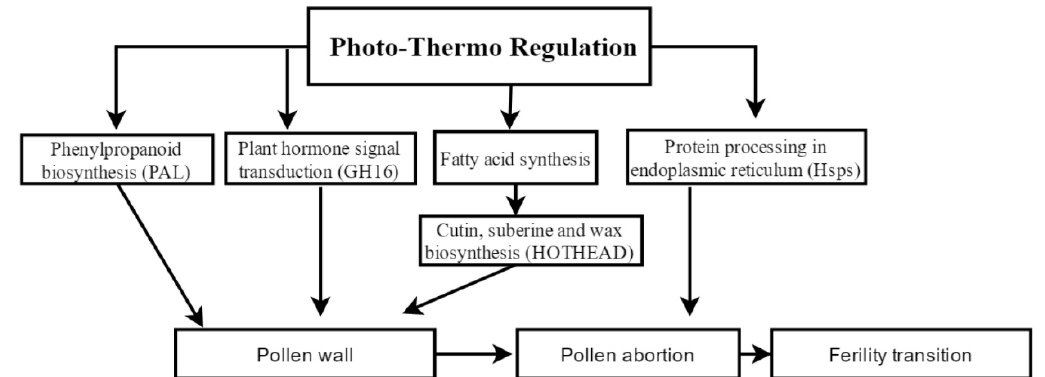
Figure 5. The proposed model of fertility transition mechanism in the PTGMS rice line WXS. Hsps, heat shock proteins; GH16 , glycosyl hydrolases family 16; PAL , phenylalanine ammonia-lyase.